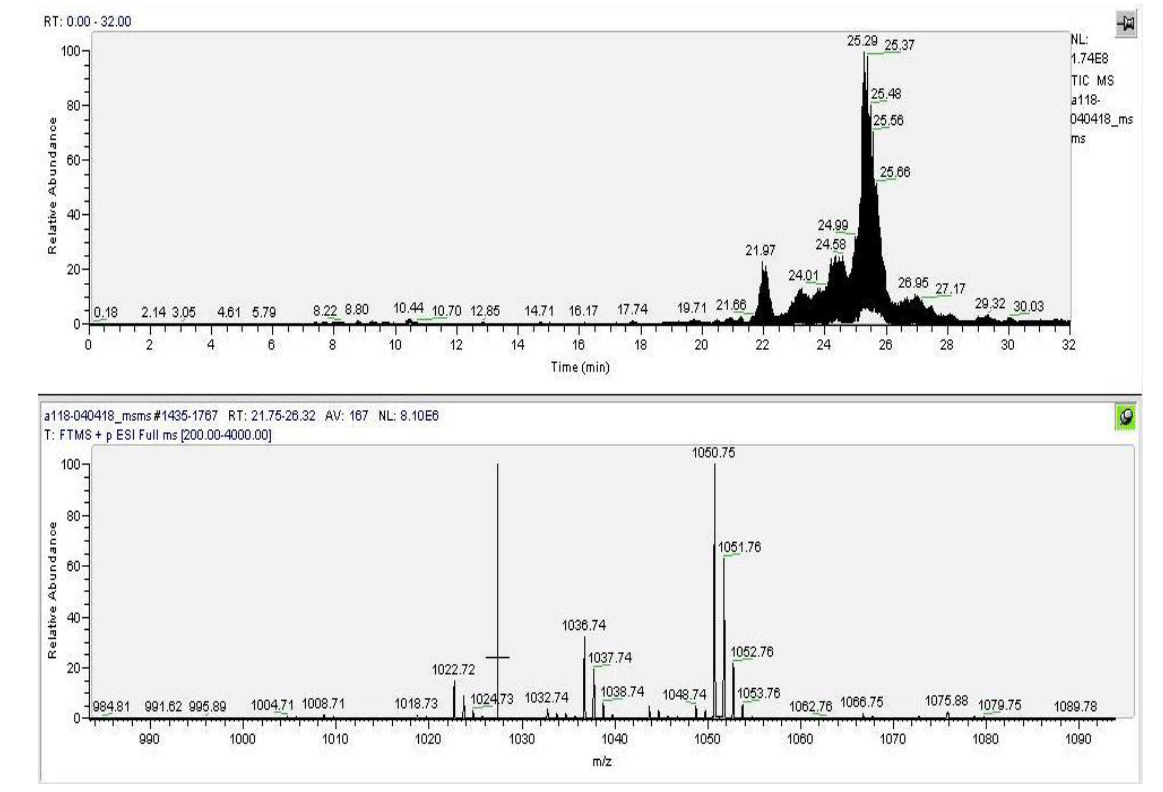
Figure 3. Electro spray ionization–mass spectrometry (ESI–MS) profile of the mixture fraction containing components A, B, C, D, and E. Designations: Ion current (upper panel), m/z values, Da (down current). Table 2. Initial structural analysis of the emericellipsins